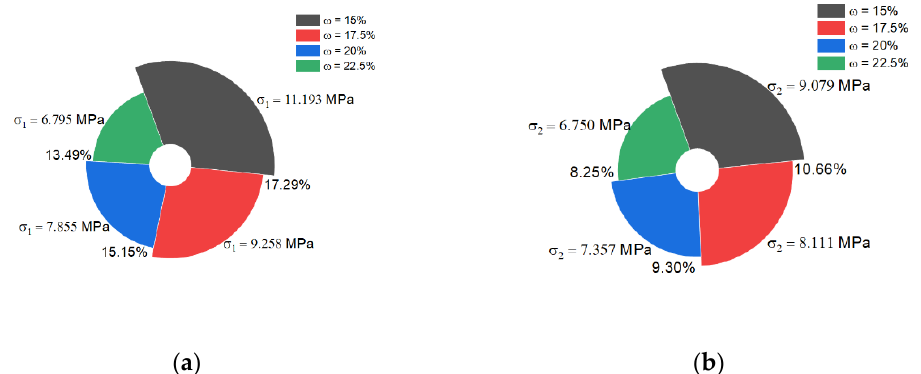
Figure 11. Distribution diagram of influence of moisture content ω : ( a ) σ 1 intensity wind rose diagram, ( b ) σ 2 intensity wind rose diagram.